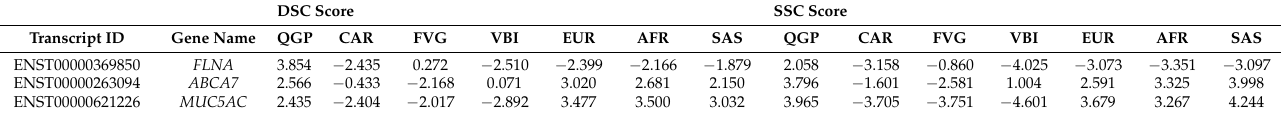
Table 3. List of genes with a concordant signature of selection between DSC and SSC scores, after the comparison between target cohorts (CAR, FVG, VBI, QGP) and the relevant reference superpopulations from the 1000 Genomes Project (EUR, AFR, SAS).